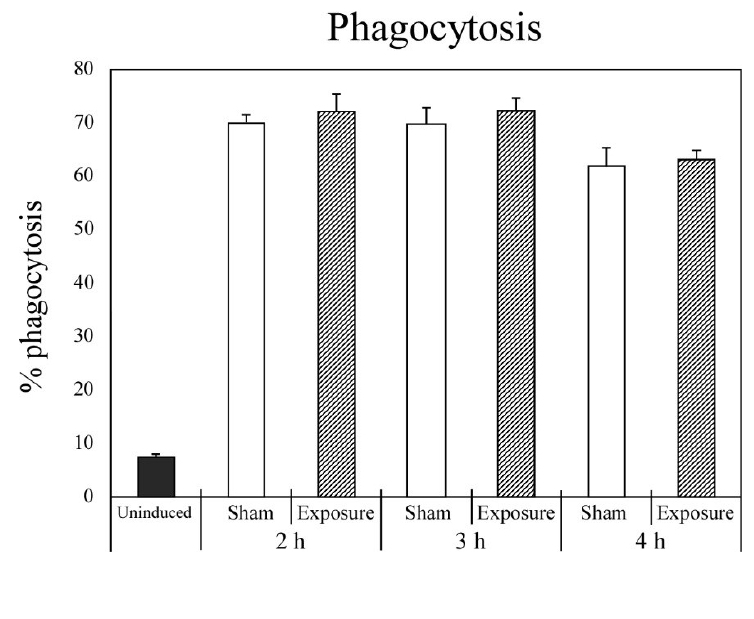
Figure 4. The percentage of microspheres phagocytosed by differentiated HL-60 cells after sham or IF magnetic field exposure for 2, 3, or 4